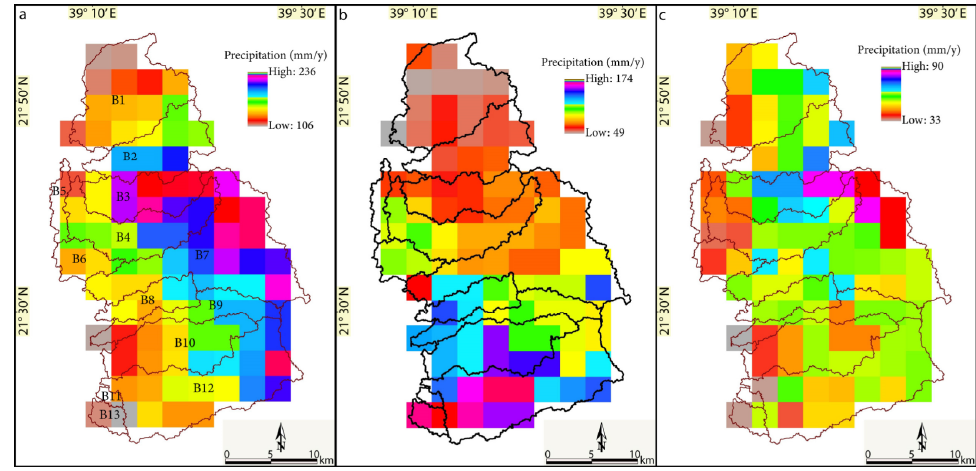
Figure 3. Precipitation pattern model from Tropical Rainfall Measuring Mission (TRMM) of ( a ) November 2009, ( b ) January 2010, and ( c ) January 2011.